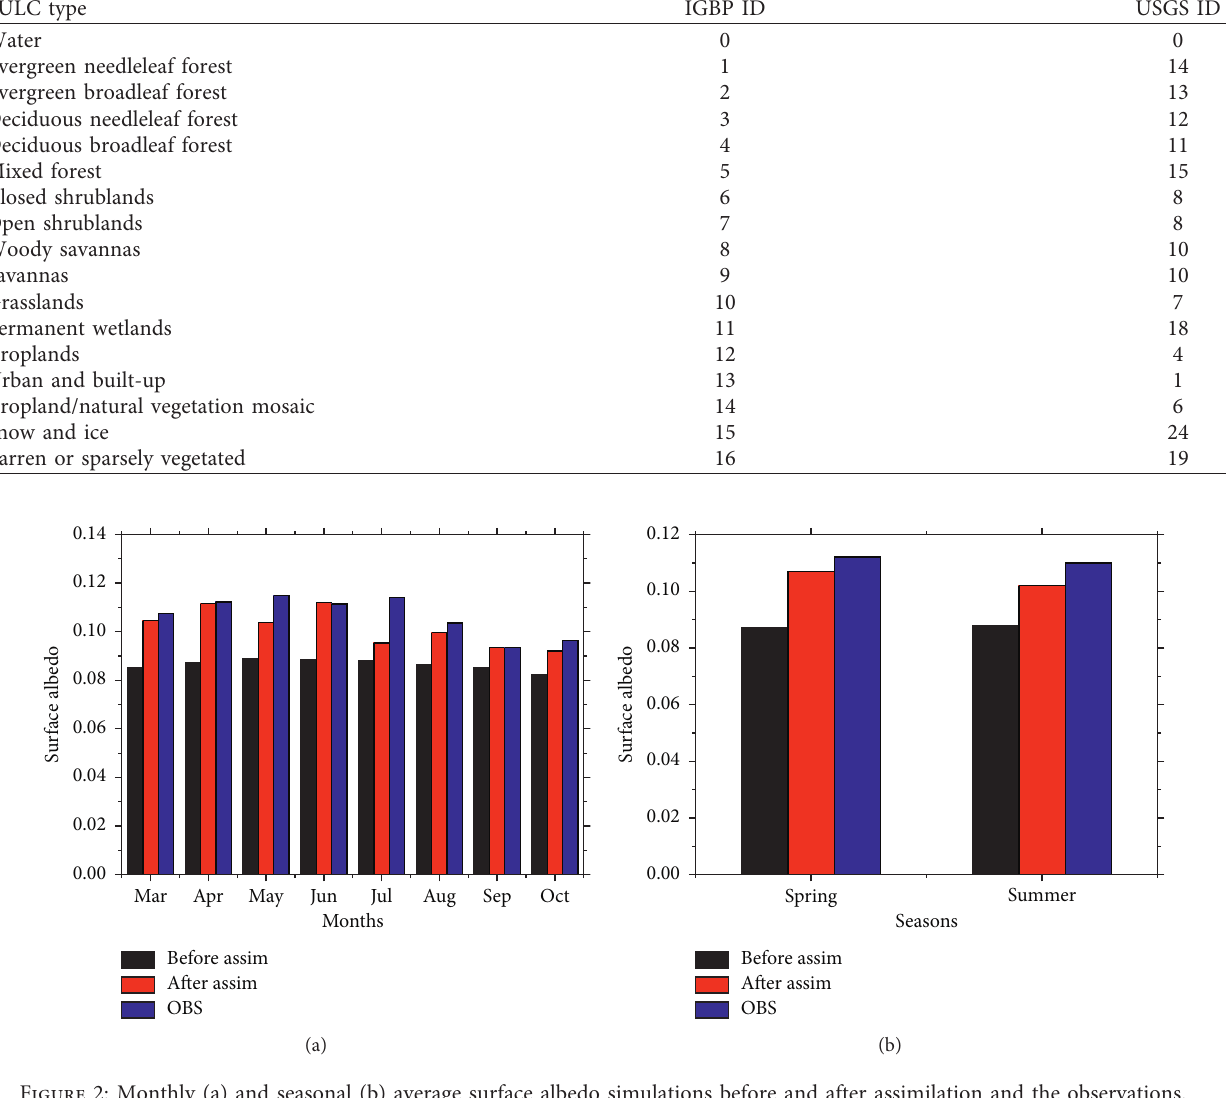
Figure 2: Monthly (a) and seasonal (b) average surface albedo simulations before and after assimilation and the